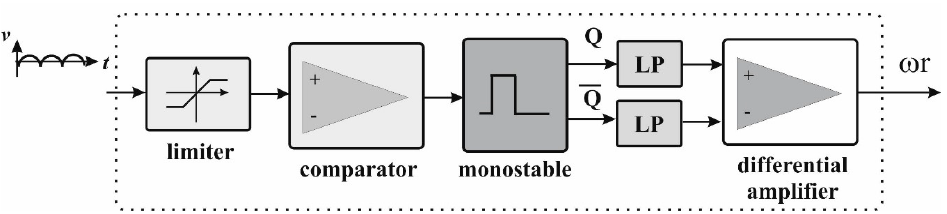
Figure 10. Block diagram of the frequency demodulator used to estimate the rotor speed based on residual ripple outputs from the